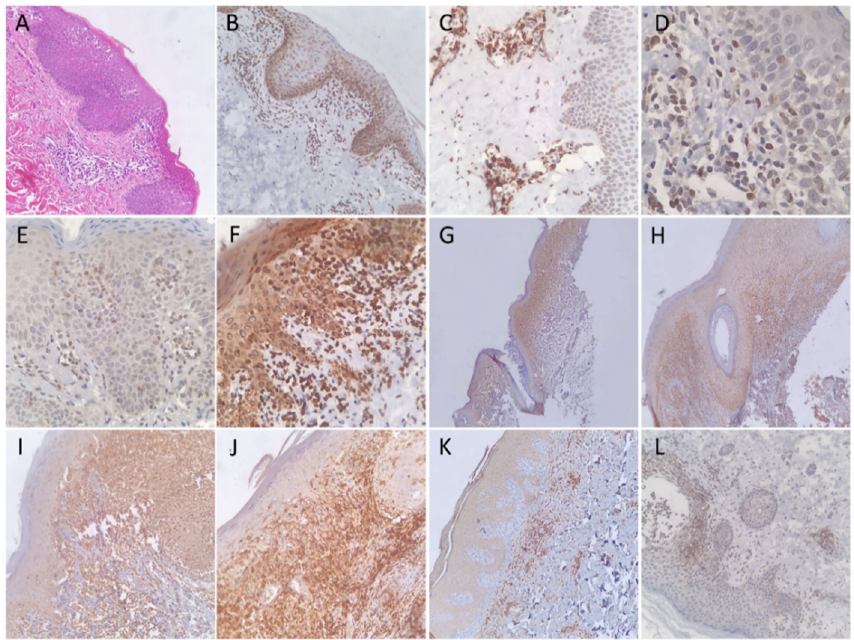
Figure 2. ( A ) Hematoxylin and eosin-stained histologic section from a patient diagnosed with suba- cute spongiotic dermatitis showing ( B ) a cytoplasmic reaction to NFkB-P105/50. The lymphocytes were positive for ( C ) CD45RO and ( D ) TOX. A patient diagnosed with psoriasis showing a positive lymphocyte reaction to ( E ) TOX and ( F ) IL-17. ( G ) Low-power view for a patient diagnosed as lichen planus demonstrating exuberant lymphocytic positivity to CD45RO, ( H ) NFkB-P105/50, ( I ) TOX, and ( J ) JAK3, while ( K ) IL-17 was negative (not shown). Another patient diagnosed as subacute spongiotic dermatitis with a positive expression of IL-17. ( L ) Another patient of spongiotic dermatitis demonstrating a positive reaction to